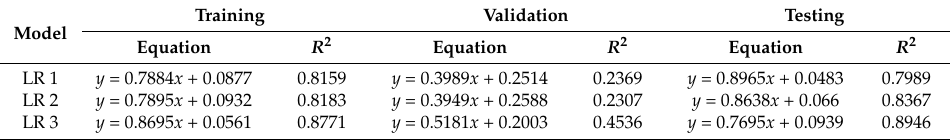
Table 8. Results of different models of LR in the training, validation, and testing phases.